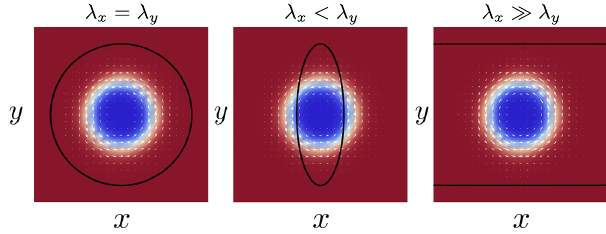
FIG. 3. Pictorial representation of a Skyrmion in the presence of a magnetic trap described by Eq. (41) for different magnetic trap sizes. The colored surface represents the out-of-plane component of the magnetization texture of a Skyrmion with positive maximum at the center (blue), while black solid line represents the size of the trap.